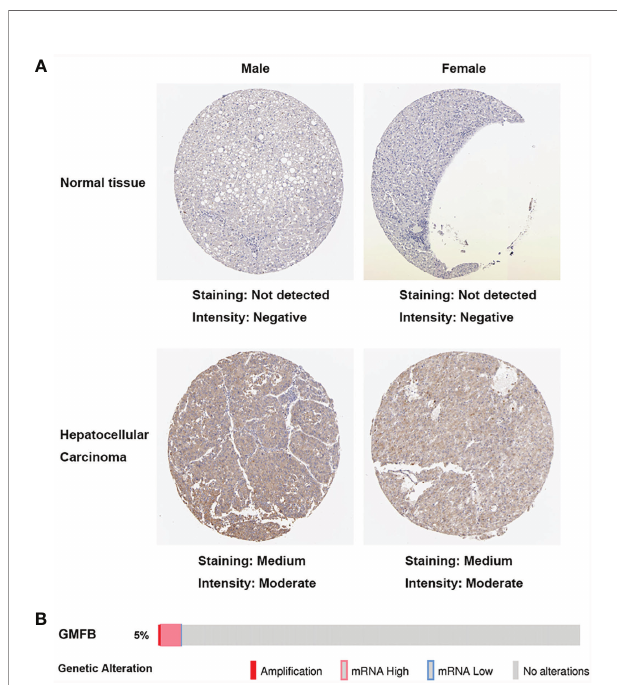
FIGURE 2 | Increased expression of GMFB in liver hepatocellular carcinoma. (A) Immunohistochemistry analysis of GMFB protein expression in normal liver tissues and hepatocellular carcinoma tissues of males and females in HPA. (B) OncoPrint of GMFB genetic alterations in HCC shows the frequency of genetic alterations included ampli fi cation, mRNA upregulation, and mRNA downregulation. The aberrant expression threshold was de fi ned as z − score